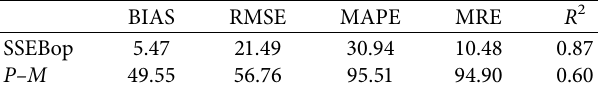
Table 2: Performance indices used to compare estimated monthly ET (SSEBop) and Penman–Monteith ( P – M ) against flux measured ET.